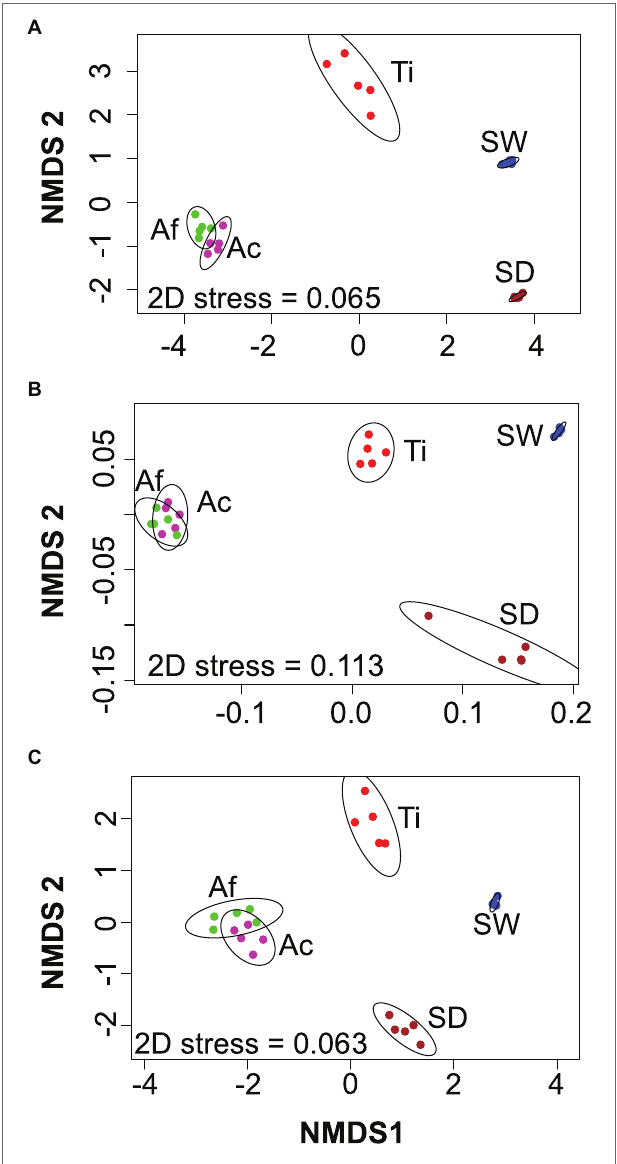
FIGURE 1 | Non-metric multidimensional scaling (nMDS) based on Bray– Curtis distances for the whole (A) , habitat generalist (B) , and habitat specialist (C) prokaryotic community. Ac, Aplysina caissara ; Af, Aplysina fulva ; Ti, Tedania ignis ; SW, seawater; and SD,